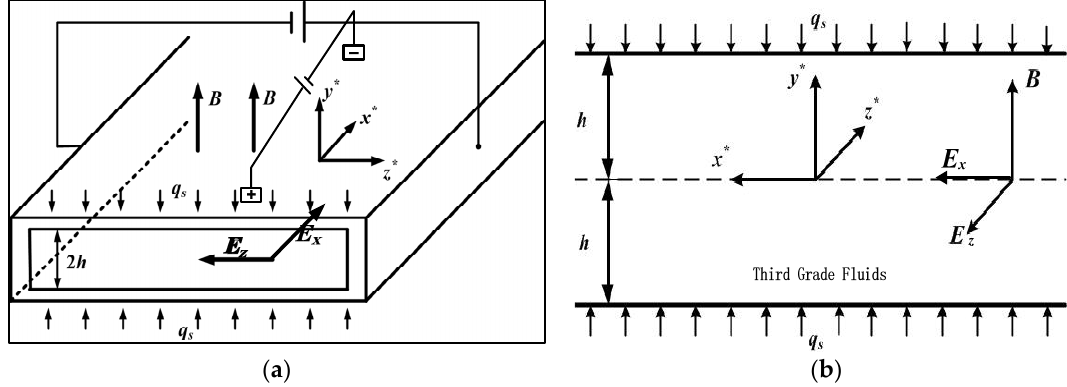
Figure 1. Schematic diagram of the physical model. ( a ) Three-dimensional (3D) view of the electromagnetohydrodynamic (EMHD) micro-pump; ( b ) Duct’s cross section of the EMHD micro-pump.